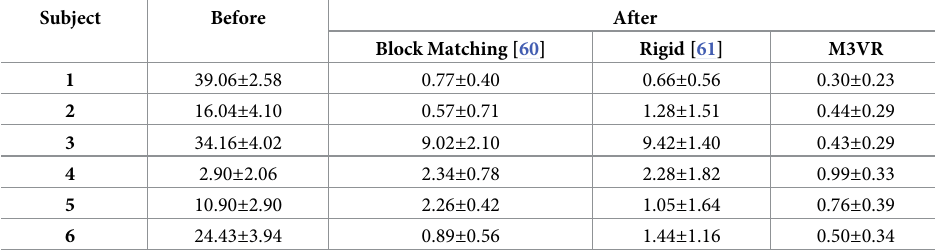
Table 2. Cross validation results on the registration accuracy of the pubic bone. MDE—Mean Distance Error (mm).